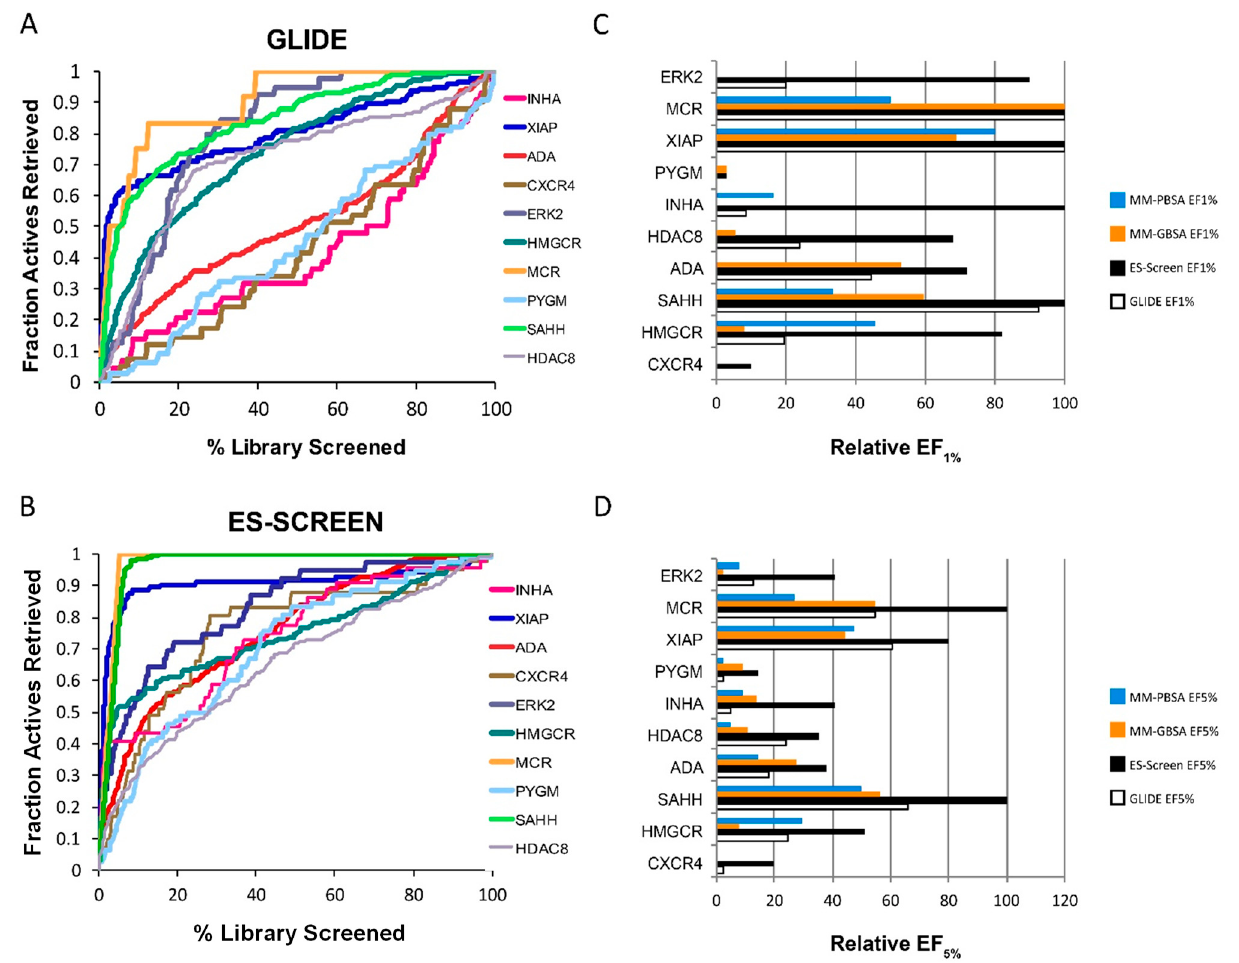
Figure 3. Virtual screening performance using DUD-E benchmarks. ( A , B ) Receiver operating characteristic (ROC) curves for ( A ) GLIDE-SP docking and ( B ) ES-Screen. ( C , D ) Relative enrichment factors of ( C ) the top 1% and ( D ) the top 5% for GLIDE-SP docking, MM-PBSA, MM-GBSA, and ES- Screen.